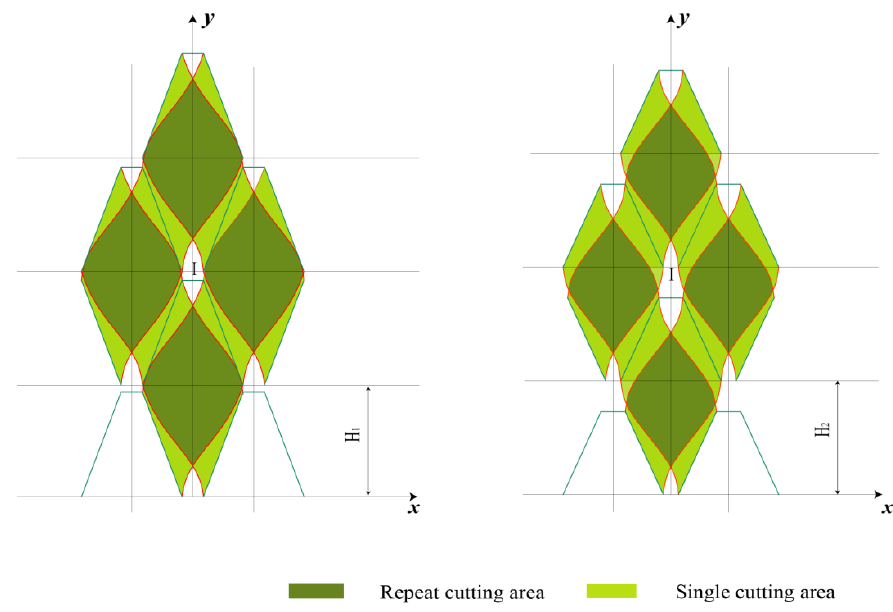
Figure 8. The cutting diagram of double-acting cutter at different advance distances.